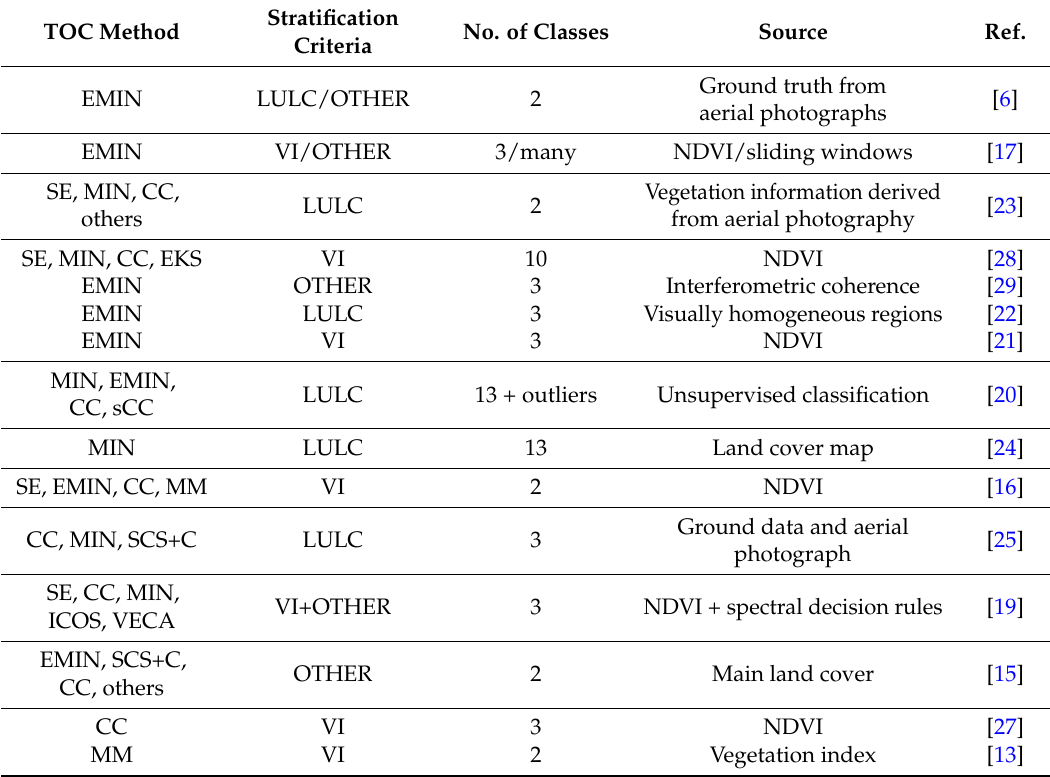
Table 1. Stratification studies published in the